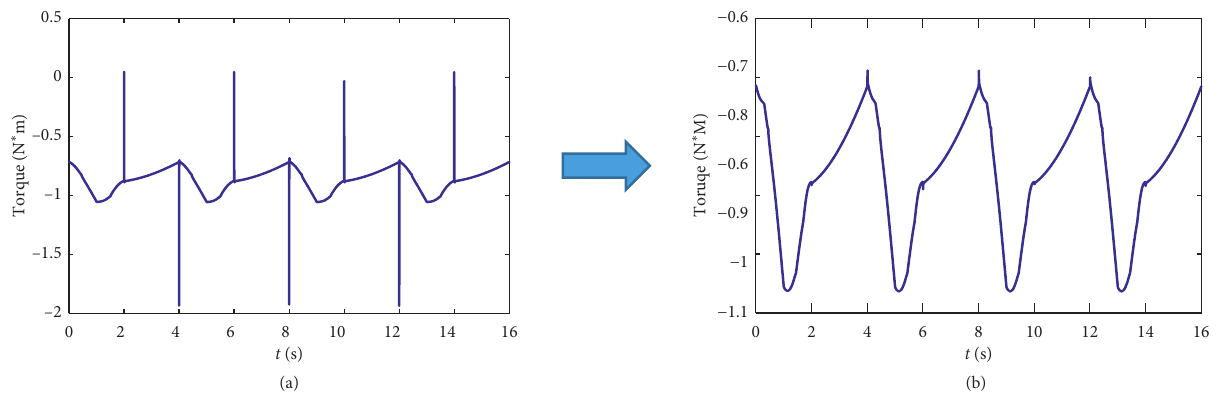
Figure 14: Driving torque curve of the shank motor. (a) Unmodified curve. (b) Modified